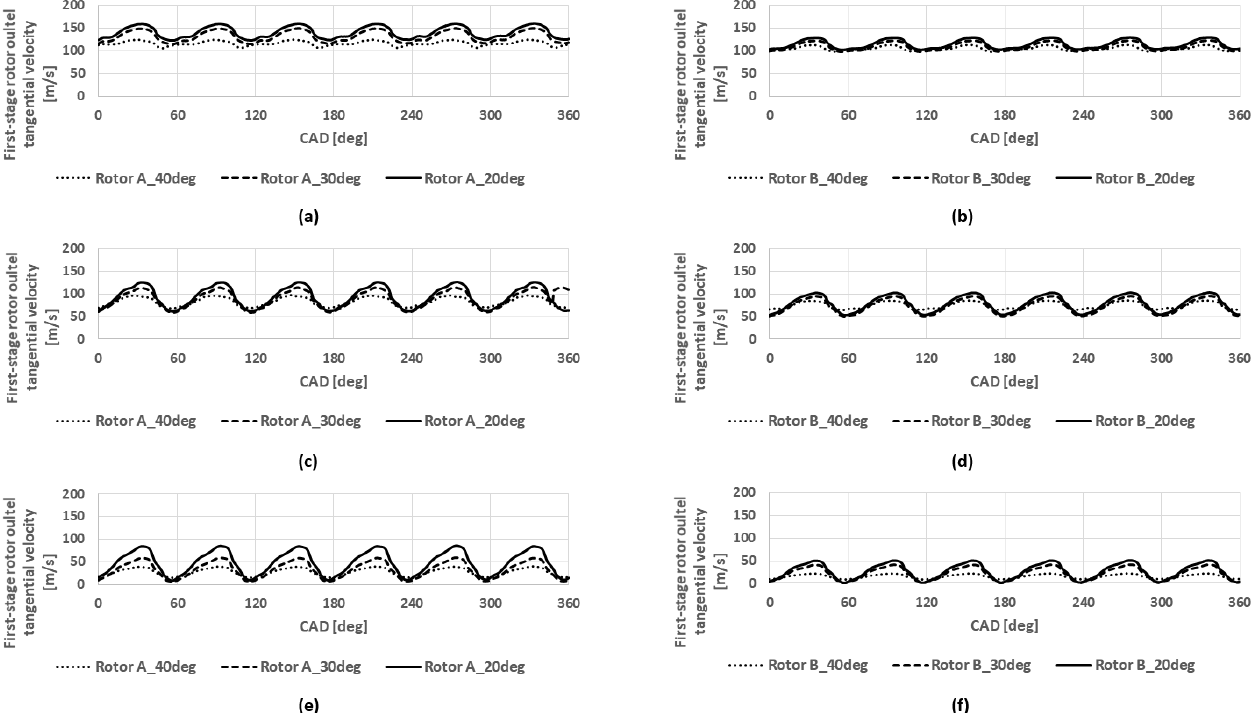
Figure 28. The area-averaged tangential velocity at the outlet from the first-stage rotor: ( a ) rotor A at 60,000 rpm, ( b ) rotor B at 60,000 rpm, ( c ) rotor A at 50,000 rpm, ( d ) rotor B at 50,000 rpm, ( e ) rotor A at 40,000 rpm, ( f ) rotor B at 40,000 rpm. Table 12. The average values of the tangential velocity at the outlet from the first-stage rotor at different turbine speed and VTG vane positions.